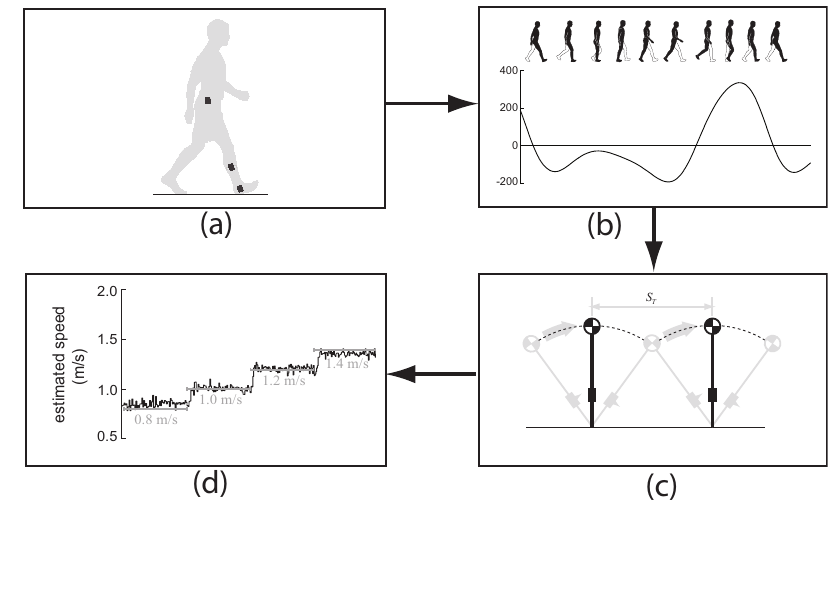
Figure 1. Generic walking speed estimation method. ( a ). Inertial sensors (accelerometer and/or gyroscope) are attached to different parts of the user. ( b ). Inertial sensors measure the accelerations and/or angular velocities which contain information related to the walking speed. ( c ). A walking speed estimation algorithm extracts the walking speed information from these sensor measurements. ( d ). Different walking speed are distinguished as outputs of the